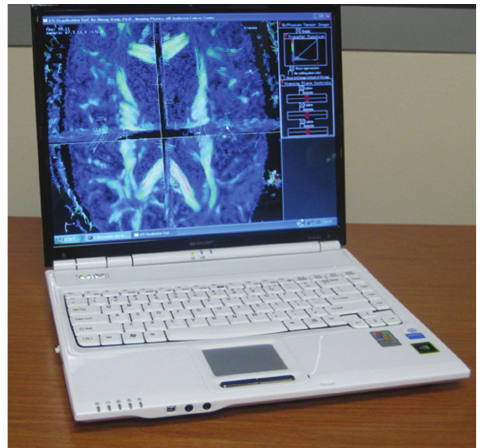
Figure 3: Photograph of the stereoscopic DTI processing and visu- alization tool. The laptop is equipped with a glasses-free LCD mon- itor. The laptop computer can operate in stereo or nonstereoscopic mode: the user can switch between modes by pushing a button. In stereoscopic mode, the LCD operates in 512 × 768 matrix size, and while in nonstereoscopic mode the LCD operates at 1024 × 768.